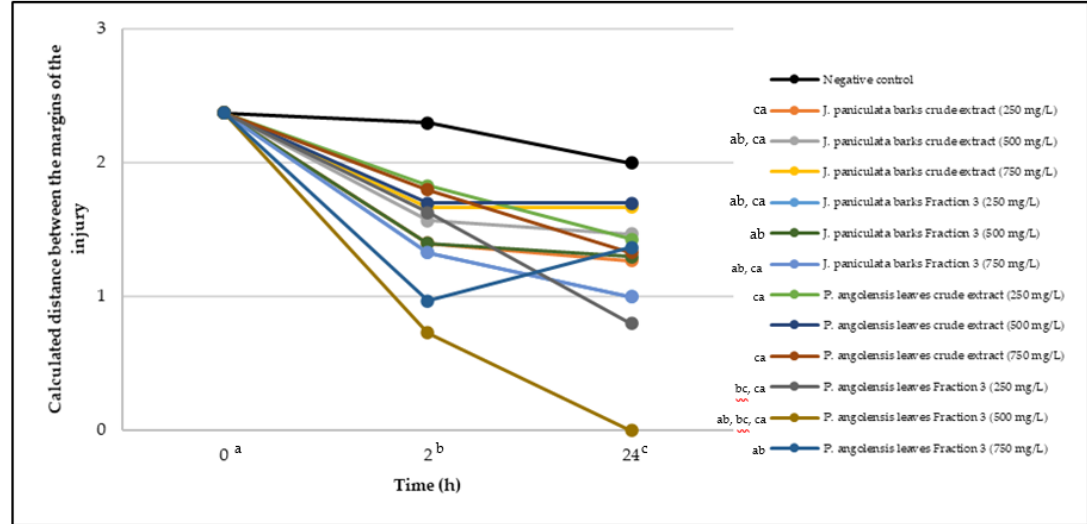
Figure 1. Calculated distance between the margins of the injury (upper letters were used to identify the statistical comparisons, indicating in the samples the pairs that presented significant results ( p -value < 0.05)). Table 8. Calculated mean difference between the distance of the injury of the negative control and the samples.